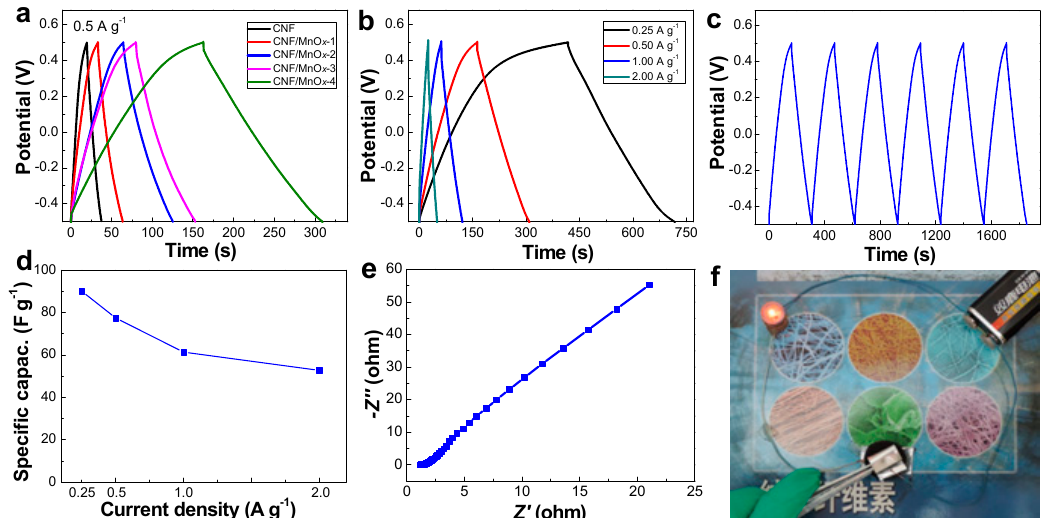
Figure 6. Galvanostatic charge–discharge (GCD) curves of the electrode made of CNF/MnO x electrodes. ( a ) Charge–discharge curves of CNF/MnO x electrodes in a three-electrode configuration measured at a constant current of 0.5 A g − 1 . ( b ) Charge–discharge curves of CNF/MnO x -4 electrode at different current densities. ( c ) GCD curves of CNF/MnOx-4 electrode at a constant current of 0.5 A g − 1 . ( d ) Specific capacitance vs. current density of the CNF/MnO x -4 electrode. ( e ) Nyquist plot for CNF/MnO x -4 electrode. ( f ) Optical image shows the electroconductivity of CNF/MnO x -4 electrode in a serial circuit.